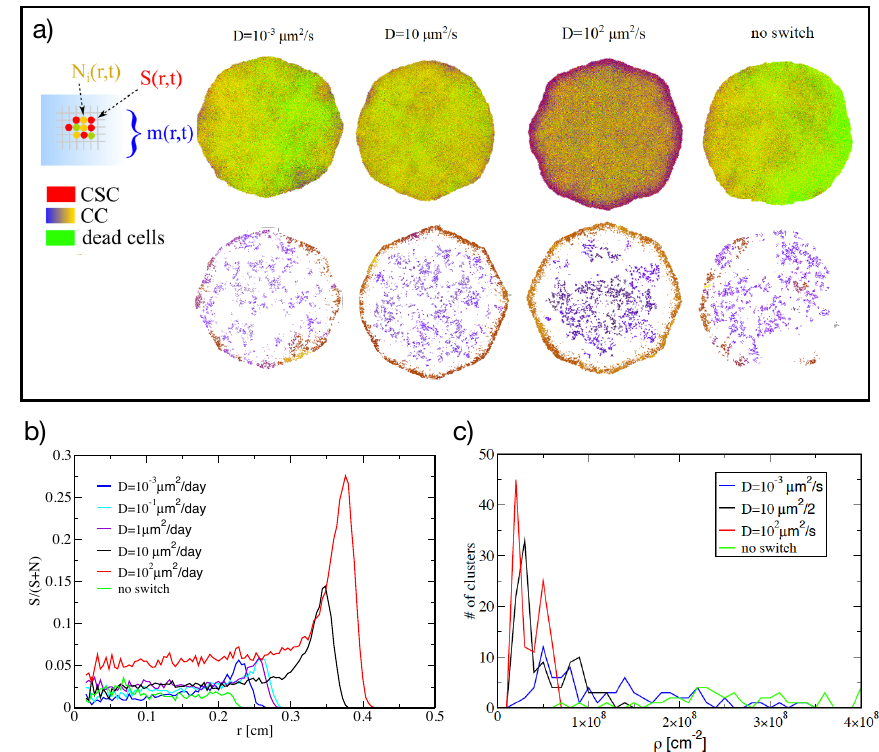
Figure 2. Two-dimensional model ( a ) A sketch of the lattice model used for the calculations is shown on the left. Top panels show snapshots displaying the spatial arrangements of CCs of different ages and of CSCs for different values of the diffusion constant D . Below each panel, we display CSCs clusters, subtracted their density halo and colored it differently for each cluster for the same values of D . All the panels are obtained after 30 days of growth. ( b ) The radial density profile of the fraction of CSCs after 30 days of growth, with τ = 4, for different values of D and for the model without switching. ( c ) The histogram of densities of the different